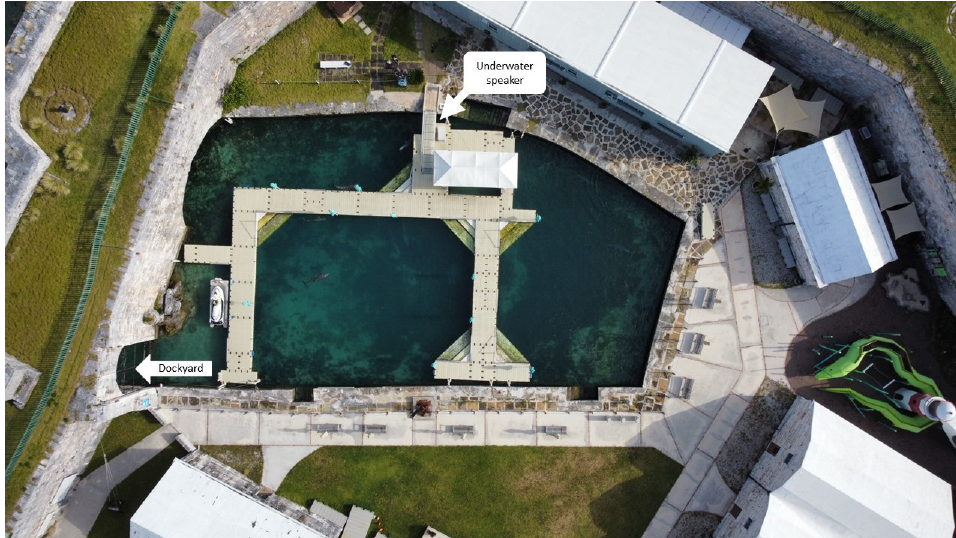
Figure 1. Location of playback trials. The playback speaker location is pictured with the arrow extending to the location below the dock at which the speaker was placed in the water. The white arrow labelled dockyard indicates the ocean gate in which sounds from the port flows through. Photo Credit: Savannah Damiano, Bruck Lab.